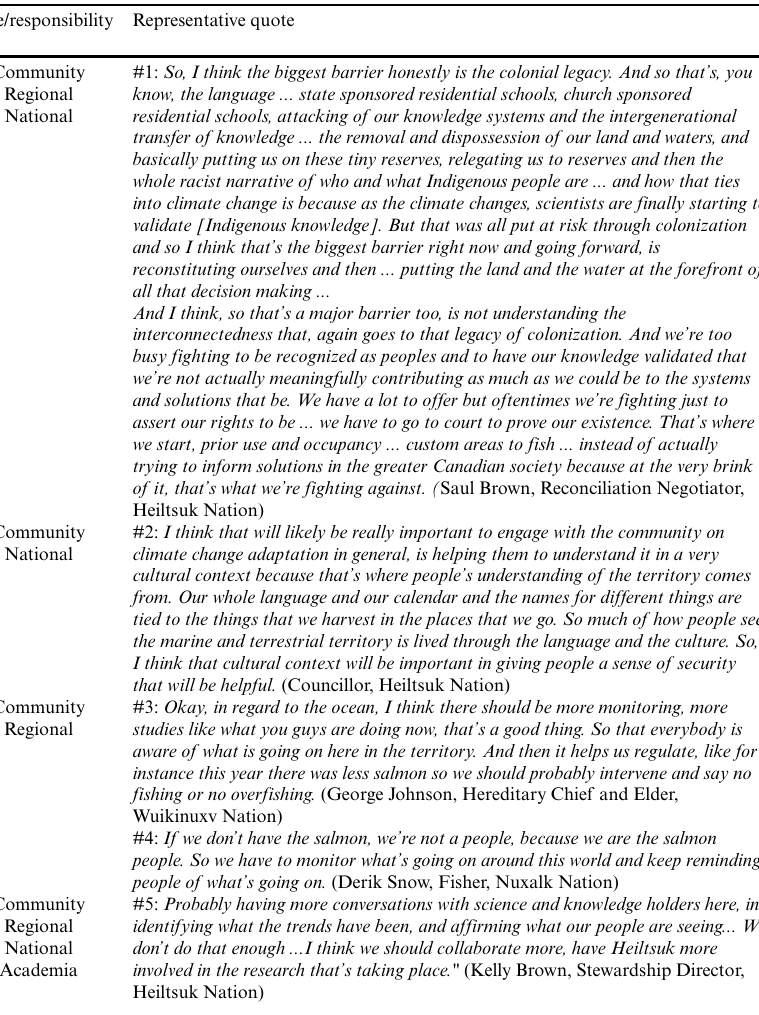
Table 5 . Adaptation actions suggested by interview participants for particular scales of management and priority adaptation